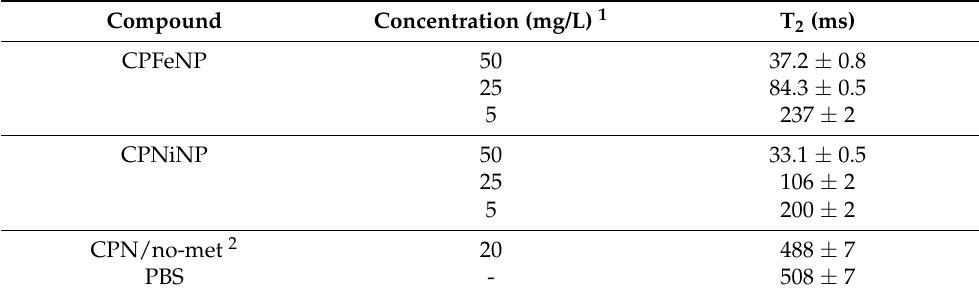
Table 2. T 2 values determined from T 2 maps of IONP ‐ doped CPNs at different concentrations.